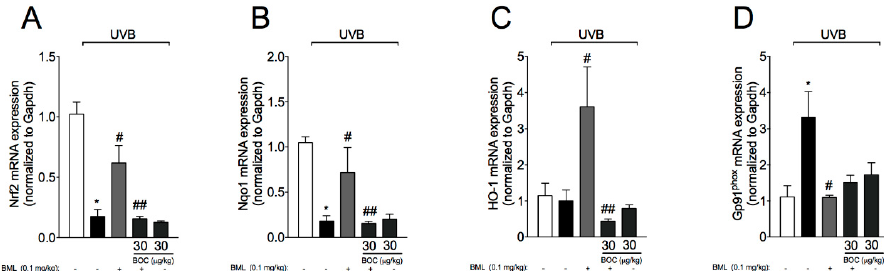
Figure 8. BML-111 increases mRNA expression of Nrf2 signaling pathway and reduces gp91 phox . Skin samples were dissected 4 h after the radiation to determine the mRNA expression of Nrf2 ( A ), Nqo1 ( B ),